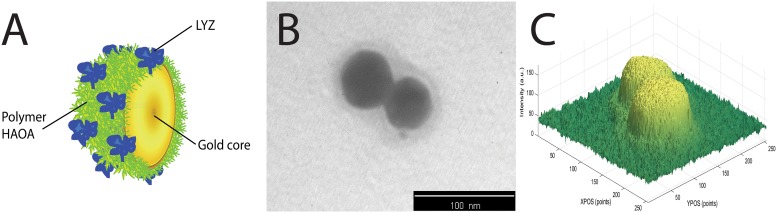

A) Representative illustration of LYZ-conjugated HAOA coated gold nanoparticles; B) TEM image of HAOA coated gold nanoparticles (non-conjugated) at scale bar: 100 nm; and C) Intensity analysis of the HAOA gold nanoparticles TEM image.